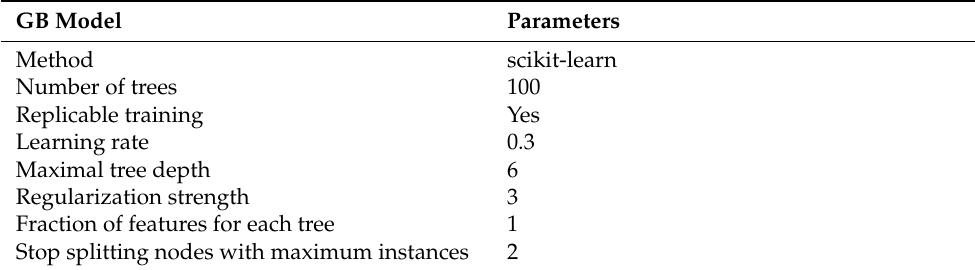
Table 3. The parameters of GB algorithm.